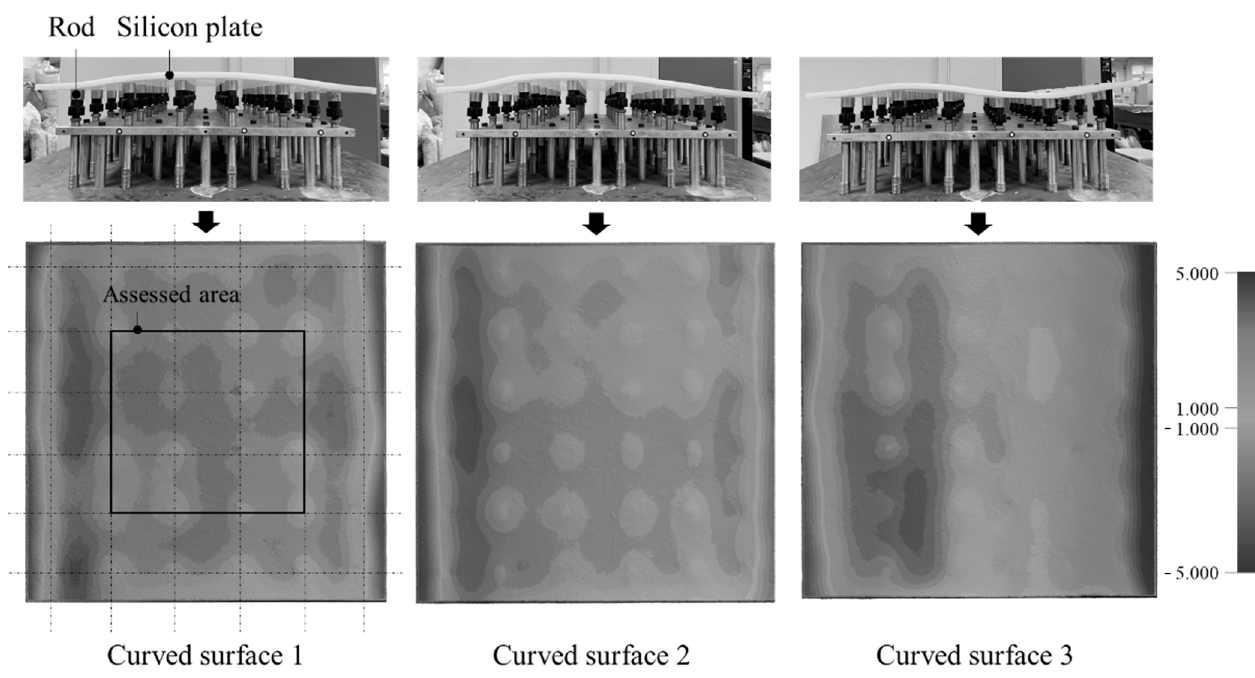
Figure 8. Production of curved surfaces.